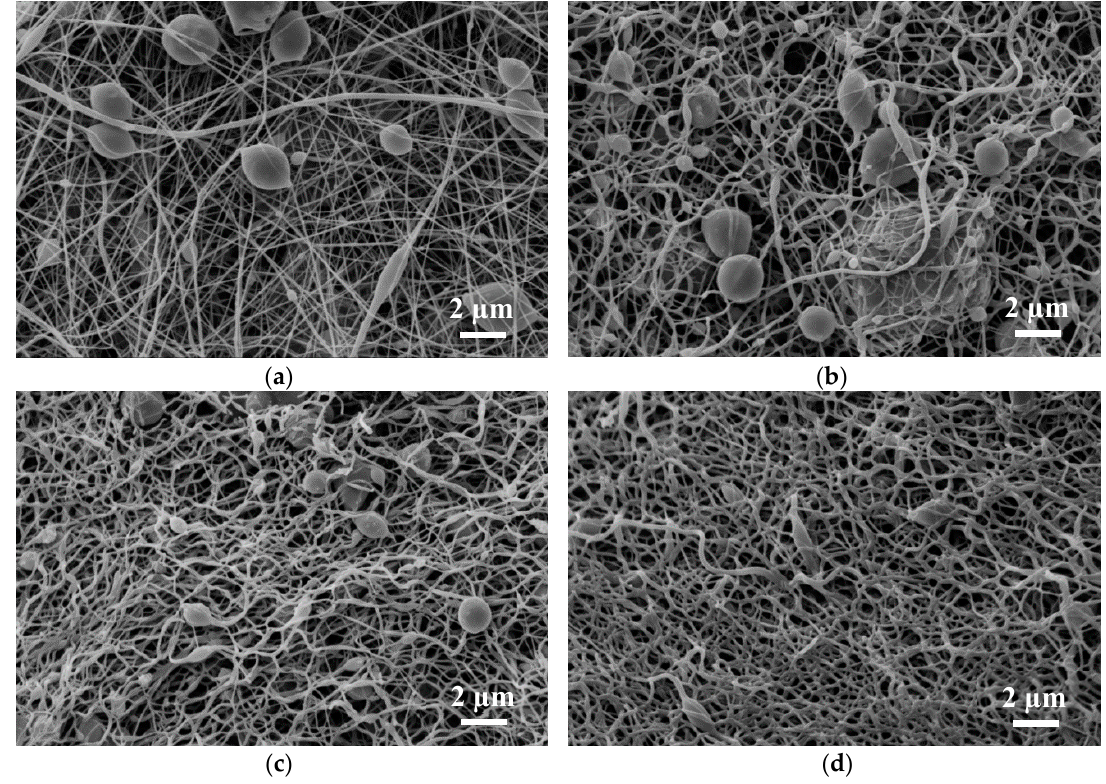
Figure 3. SEM images of PAN/nickel-ferrite nanofiber mats: ( a ) after electrospinning; ( b ) after stabilization; ( c ) after carbonization at 500 °C; ( d ) after carbonization at 800 °C.